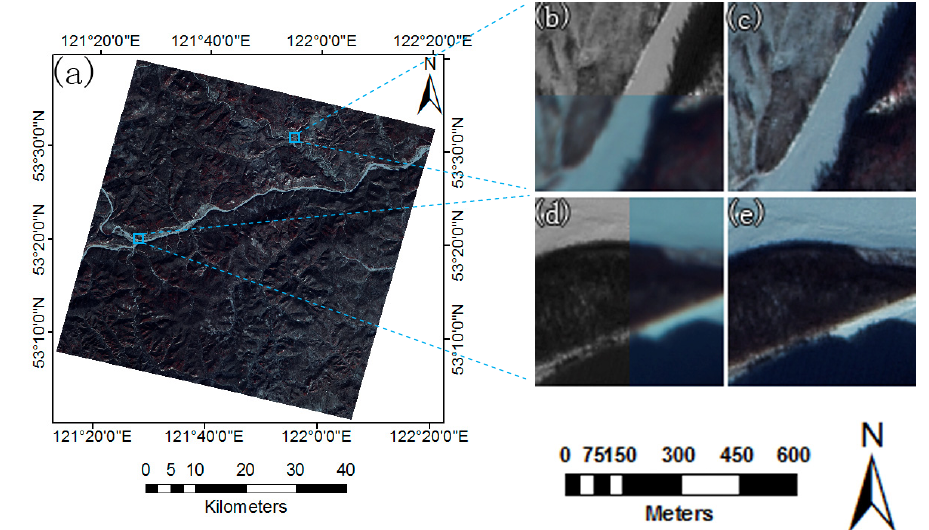
Figure 7. Registration and fusion results of Dataset 1. ( a ) provides an overall view of fused images, ( b ) shows the swipe effect of registered images in the first cyan rectangular area, ( c ) shows the fusion result, ( d , e ) show the result in the second rectangular area.